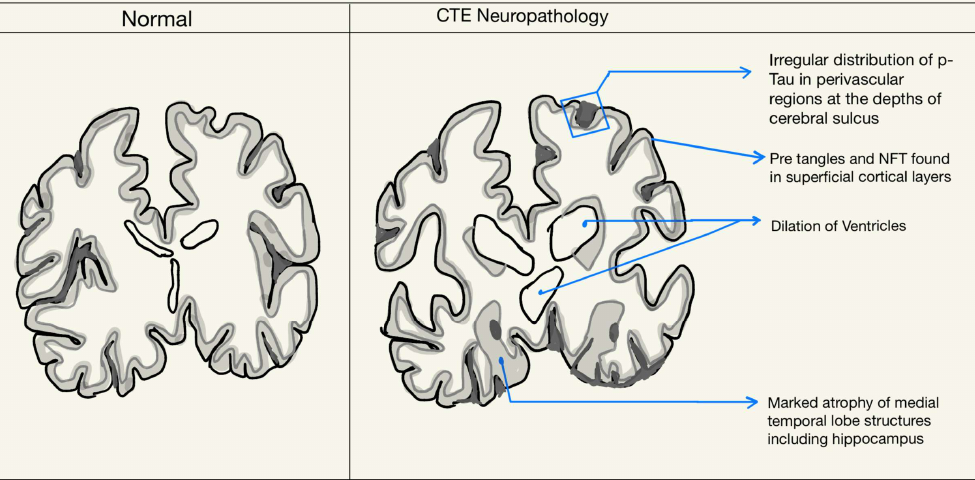
Figure 1. The progression of hyperphosphorylated p-Tau.